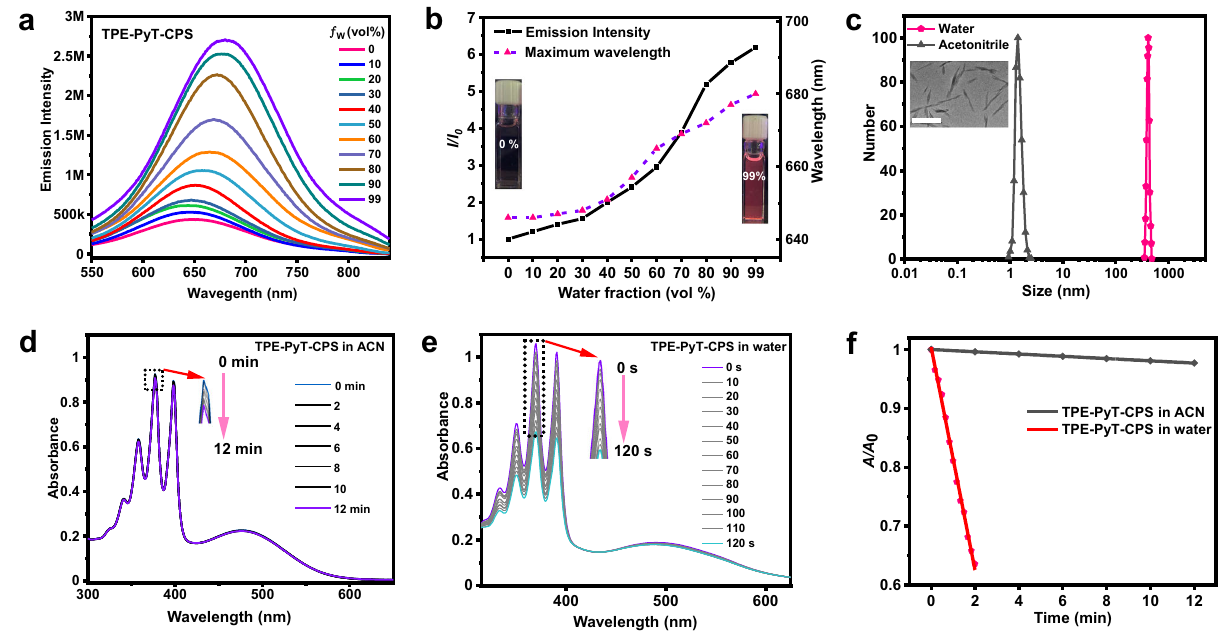
Fig. 2 AIE characteristics of TPE-PyT-CPS and its ROS generation ability in different solvents. a Emission spectrum of TPE-PyT-CPS in acetonitrile/ water mixtures with varied water fractions ( ƒ w ). b Emission intensity plot of I/I 0 (dark dot) and the maximum emission wavelength (red dot) of TPE-PyT- CPS in different ƒ w of the solvent mixture, I 0 represents the emission intensity in acetonitrile. c The particle sizes of TPE-PyT-CPS (10 μ M) in water and acetonitrile was measured by dynamic light scattering. Inset: TEM images of TPE-PyT-CPS in water. Scale bar:1 μ m. Changes of UV-vis spectra of ABDA (60 μ M) in the presence of TPE-PyT-CPS (10 μ M) in acetonitrile ( d ) and water ( e ) under different durations of light irradiation (10 mW cm -2 ). f The decomposition rates of ABDA in different solvents in the presence of TPE-PyT-CPS under light irradiation (A 0 and A represent the absorption of ABDA before and after laser irradiation, respectively). Experiments in 2a-f were performed two times independently and experiments in 2c (insert) were performed three times independently, representative images are shown. Source data are provided as a Source Data fi le.